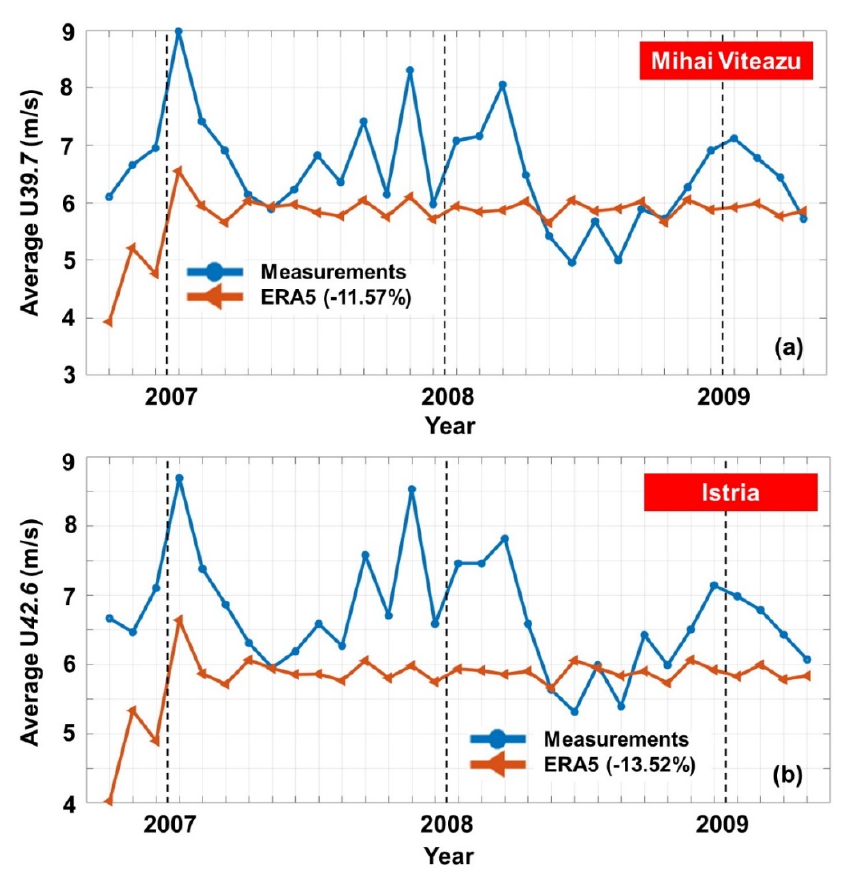
Figure 3. Wind speed comparison between ERA5 and in situ measurements, considering the time interval October 2006 to April 2009. Results for: ( a ) Mihai-Viteazu site, at 39.7 m height; ( b ) Istria site, at 42.6 m height. The in situ values were adapted from [30]. The percentage values indicate the average differences (in %) between ERA5 and in situ data, in this case ERA5 underestimating the wind speed.